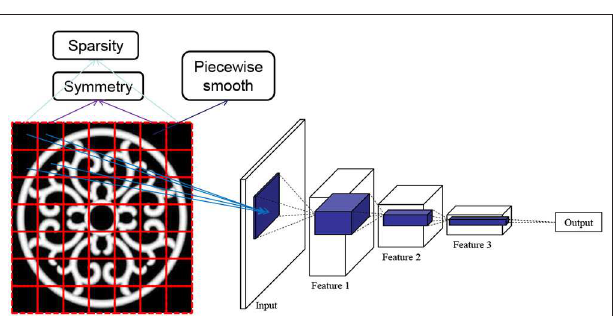
FIGURE 4 | DCNN in image